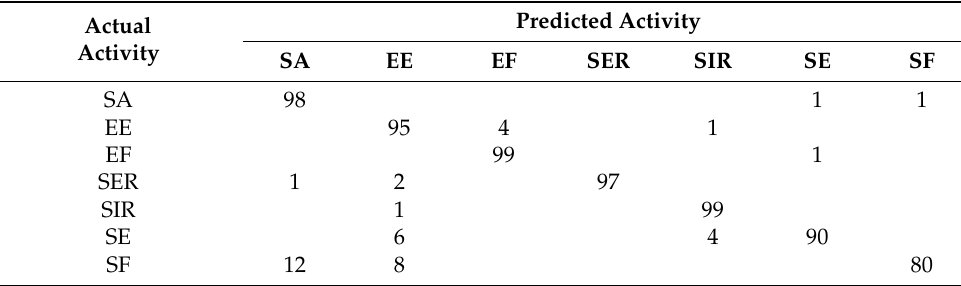
Table 6. Confusion matrix for NB classifier (in %). Cells with value 0 are left blank.